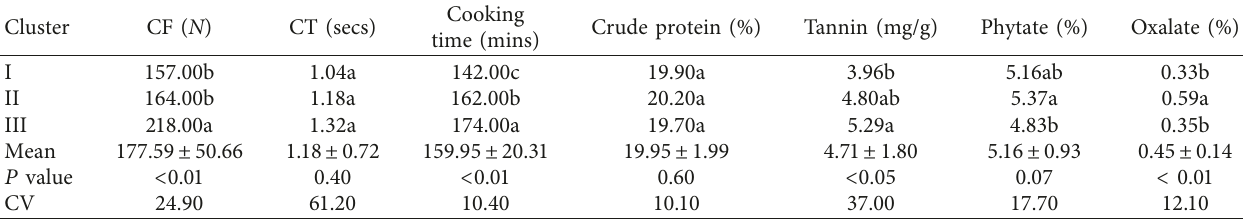
Table 3: Analysis of variance of the physical and chemical composition of 93 AYB accessions by hierarchical cluster.